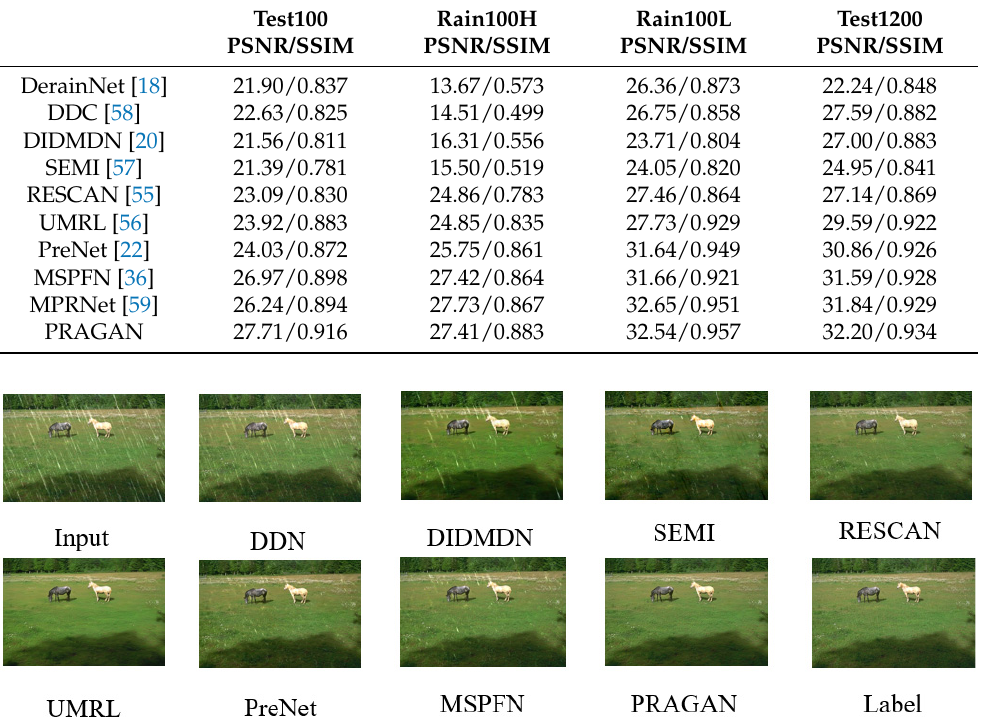
Figure 8. Deraining results from the Rain100L [19] testing set. Rain100L [19] consists of 100 image pairs for testing with one type of rain streak. It can be seen from the figure that most of the methods can remove rain streaks to a certain extent, but our PRAGAN can almost remove all the rain streaks compared with other methods, and restore images closer to ground truth.